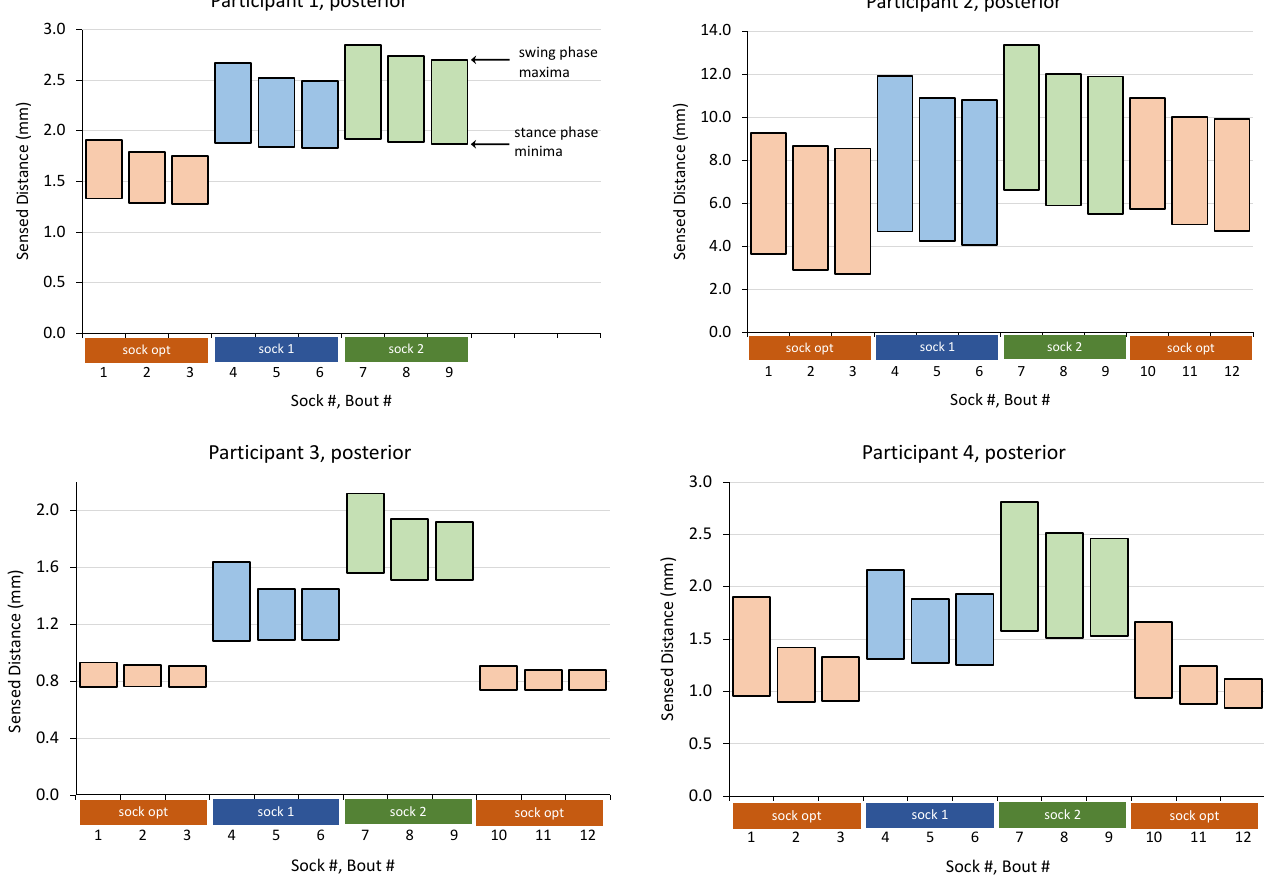
Figure 5. In-lab test results. Results from the posterior sensor for each participant are shown. Each bar shows the range of vertical limb motion, where the top is the median maximum position for the last 10 steps in the cycle and the bottom is the median minimum position for the last 10 steps in the cycle. Maxima occurred during swing phase, and minima occurred during stance phase. Minimum distance (bottoms of the bars) increased for all sock additions and reduced for all sock reductions. Limb-socket vertical motion (length of the bars) increased for all sock additions and decreased for all sock reductions expect for participant 2′ s posterior location for sock 1 to sock 2. Limb cyclic vertical motion (length of the bars in Figure 5) increased when sock ply was increased except for the posterior location for participant 2 for sock 1 to sock 2. The median cyclic vertical motion change for a sock ply increase was 0.19 mm (range − 0.37 to 1.65). Cyclic vertical motion decreased when sock ply was decreased. The median cyclic vertical motion change was − 0.50 mm (range − 1.19 to −